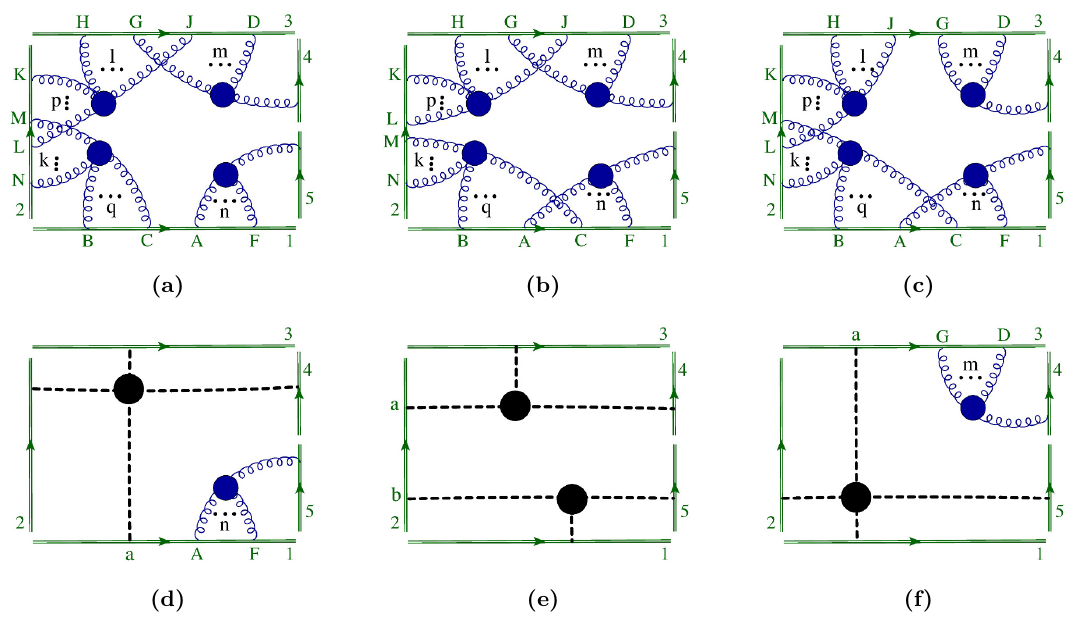
Figure 22. Fused-Webs for Cweb W (1 , 1 , 1 , 1)